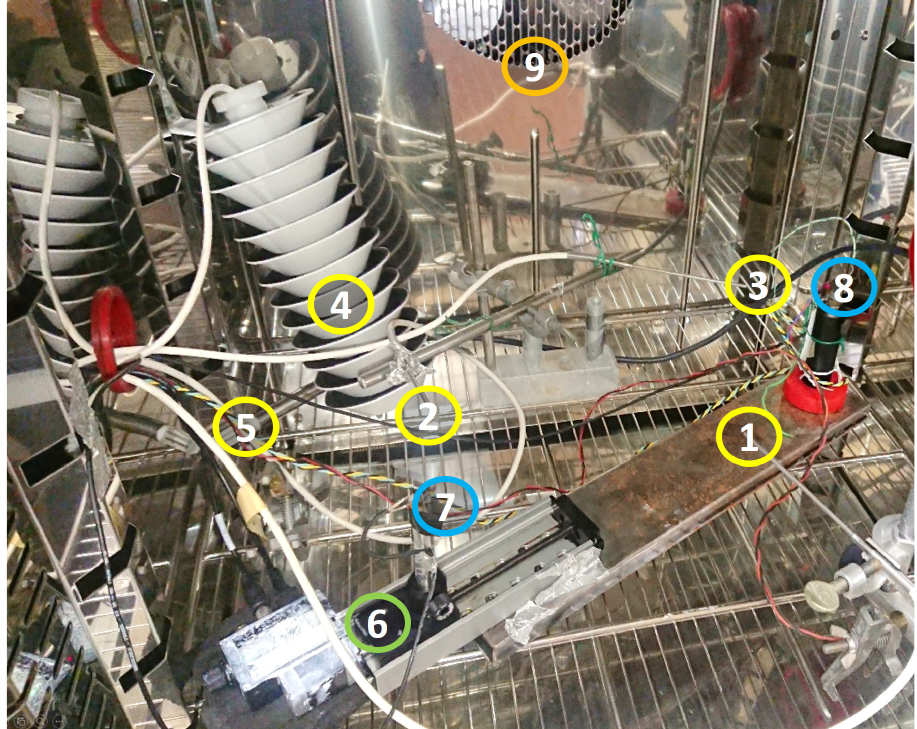
Figure 5. Picture of the experimental set-up. Points 1–4 indicate the reference platinum thermometers. Only in the case of the irradiation experiment is the thermometer marked as 4 inserted in a radiation shield as in the picture. Point 5 indicates the reference hygrometer. Point 6 is the motorized carriage. Point 7 is the piezo transmitter and 8 is the piezo receiver with the alignment laser on. Point 9 is the aperture with the fan from where the conditioned air comes out.